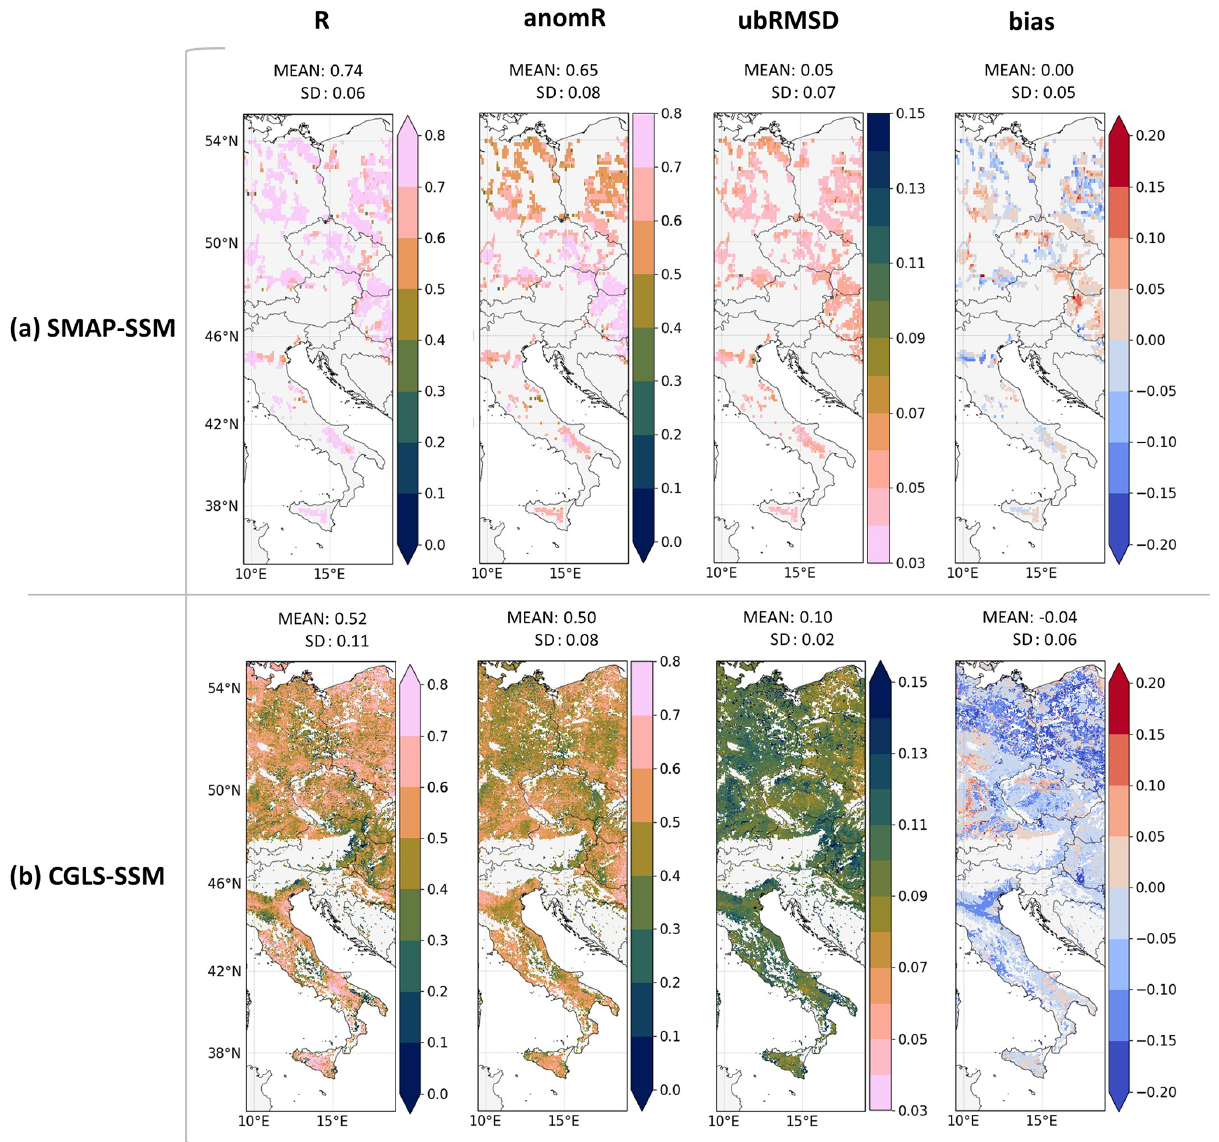
Figure 6. Temporal performance metrics of AquaCrop SSM evaluated against (a) SMAP-SSM and (b) CGLS-SSM, i.e. R (–), anomR (–), bias (m 3 m − 3 ), and ubRMSD (m 3 m − 3 ), with indication of the spatial mean and standard deviation of the metrics (MEAN, SD). Light grey areas represent no